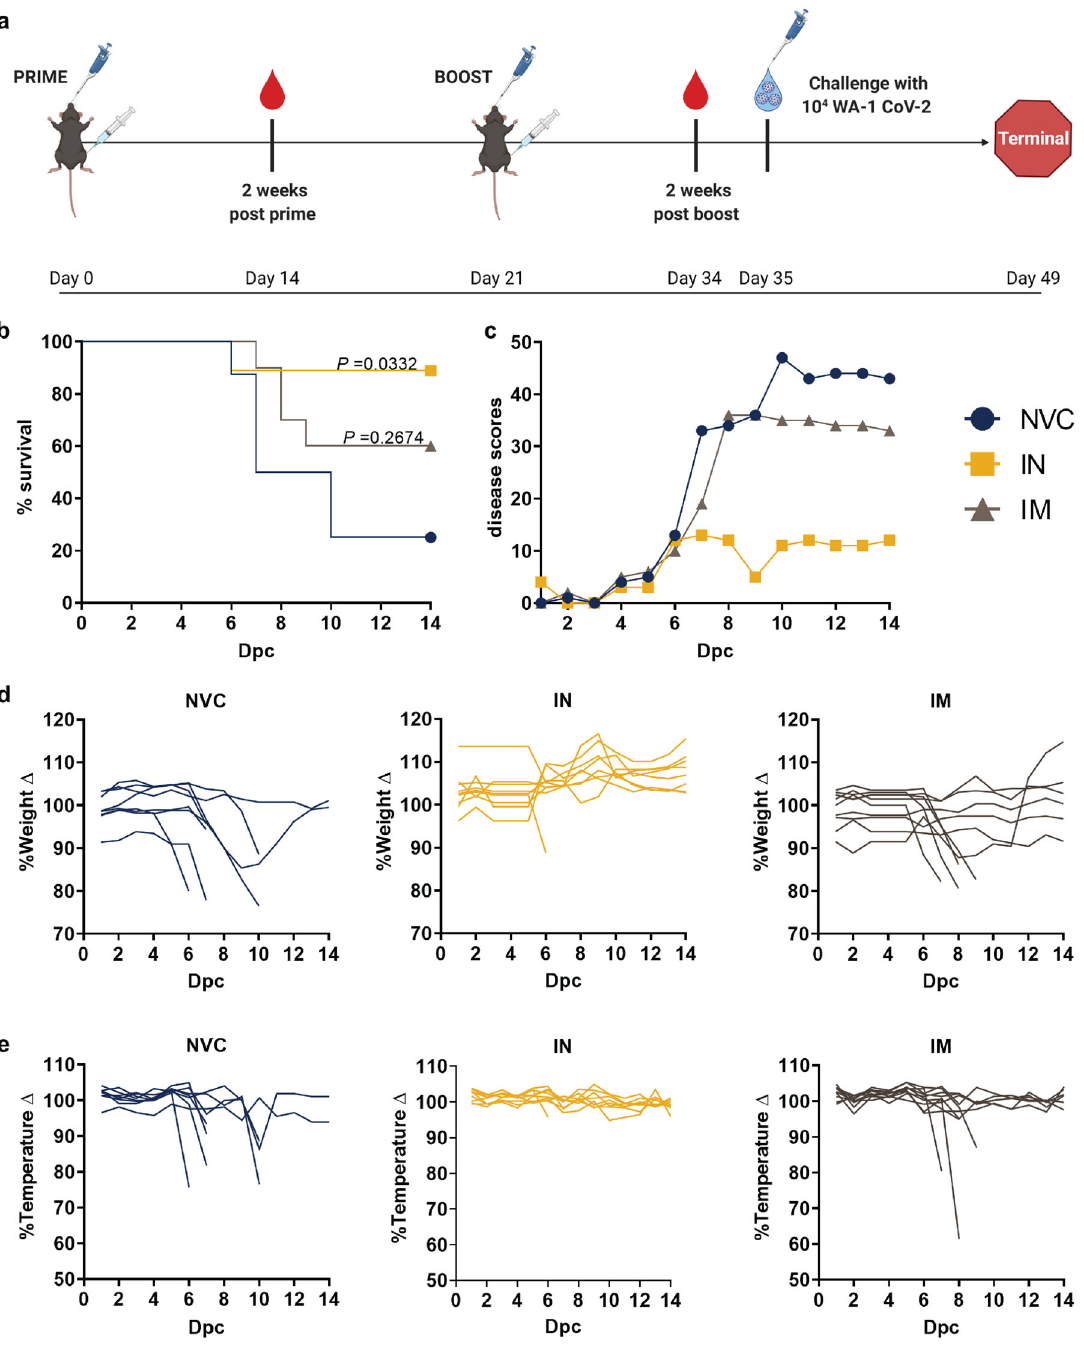
Fig. 3 Intranasal administration of BReC-CoV-2 protected mice from SARS-CoV2 challenge. a vaccine and challenge schematic in K18- hACE2 mice. Mice were primed and boosted with either IN or IM BReC-CoV-2, and blood for serological analysis was collected 2 weeks post prime and boost. Mice were challenged intranasally with 10 4 PFU/dose of WA-1 SARS-CoV-2, and mice were monitored for 14 days post challenge. b NVC ( n = 8), IN BreC-CoV-2 ( n = 9), and IM BreC-CoV-2 ( n = 10) vaccinated animals Kaplan Meier survival curve. NVC had 25%, IN had 89%, and IM had 60% survival. Log-rank (Mantel – Cox) test were used to test signi fi cance of survival between sample groups. c Disease scores were calculated each day for each mouse and added per group. If a mouse reached a disease score of 5 or above, the mouse was euthanized, but the score was retained downstream for disease score analysis. d % weight change from 100% of the NVC, IN, and IM groups. e % temperature change from 100% of the NVC, IN, and IM Both IM and IN BReC-CoV-2 RBD antibody responses increase measured before challenge and after challenge with SARS-CoV-2. during SARS-CoV-2 challenge In order to measure serum RBD IgG before challenge, blood was collected at 2 weeks post prime and 2 weeks post boost (Fig. 5a). To investigate the antibody responses generated by BReC-CoV-2 At 2 weeks post prime, both IN and IM begin to generate vaccination, we fi rst analyzed RBD-speci fi c IgG production detectable RBD IgG titers, with the IM generating higher RBD titers systemically and then locally in the lung. Systemic RBD IgG was